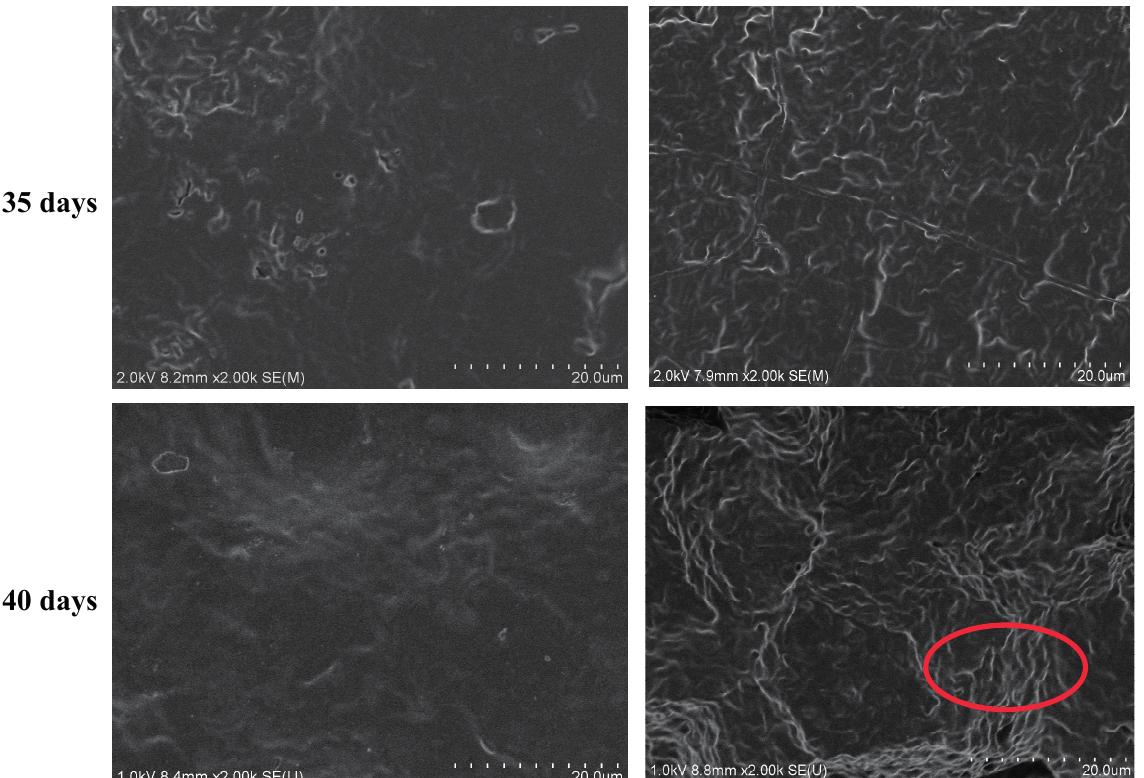
Figure 7. SEM images for the surface morphology of PLH after degradation in different phosphate butter solutions with different times: ( a ) pH 7.4 and ( b ) pH